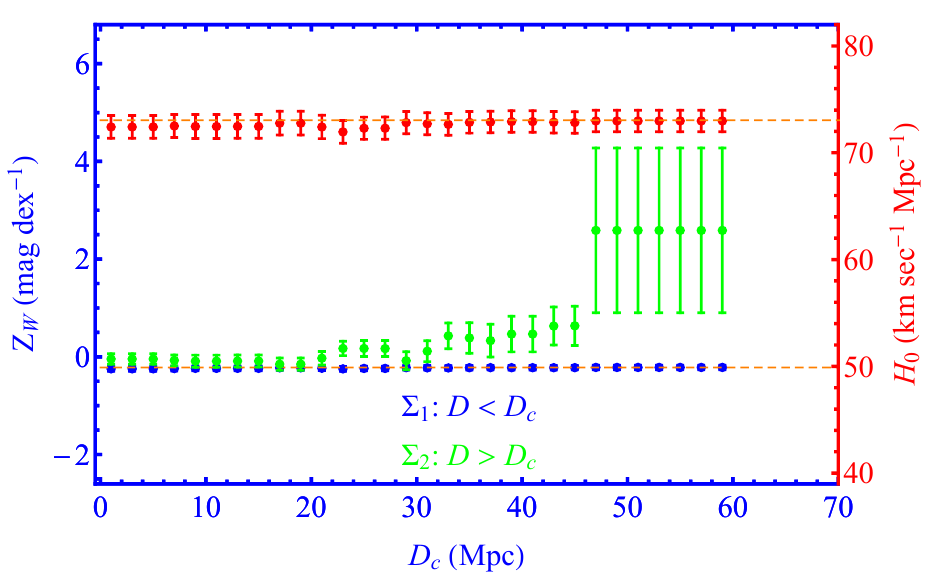
Figure 11. Same as Figure 8 in an analysis generalization where the parameter Z W is allowed to have a transition at a distance D c . Notice the sharp increase in the difference between best fit parameters − Z < | for D c > 47 Mpc. The best-fit value of the Hubble parameter of high D and low D bin | Z > W W (red points) is not significantly affected by this type of degree of freedom perhaps due to the indirect connection of Z W with H 0 .